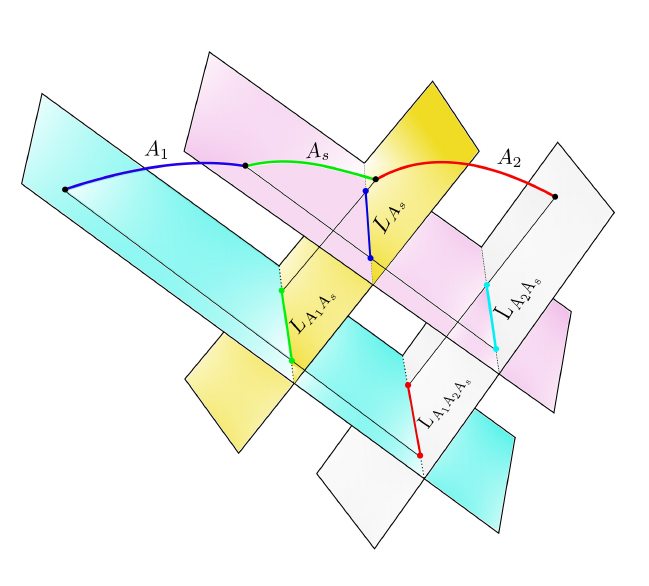
Figure 4: Schematics of the holographic construction for the computation of entan- glement negativity of two disjoint intervals. The entanglement negativity is obtained via a specific linear combination of the lengths of the bulk extremal curves situated at the crossings of the null planes descending from the endpoints of the two